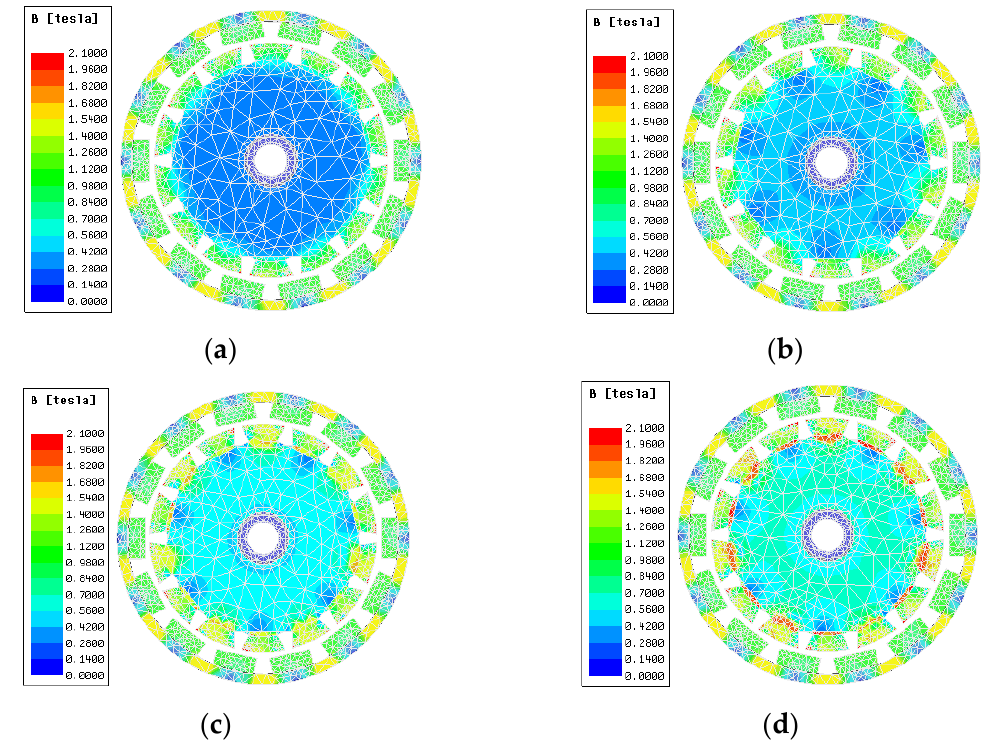
Figure 26. The magnetic field density cloud of the CPMLTM. ( a ) 0 A, ( b ) 50 A, ( c ) 100 A, ( d ) 150